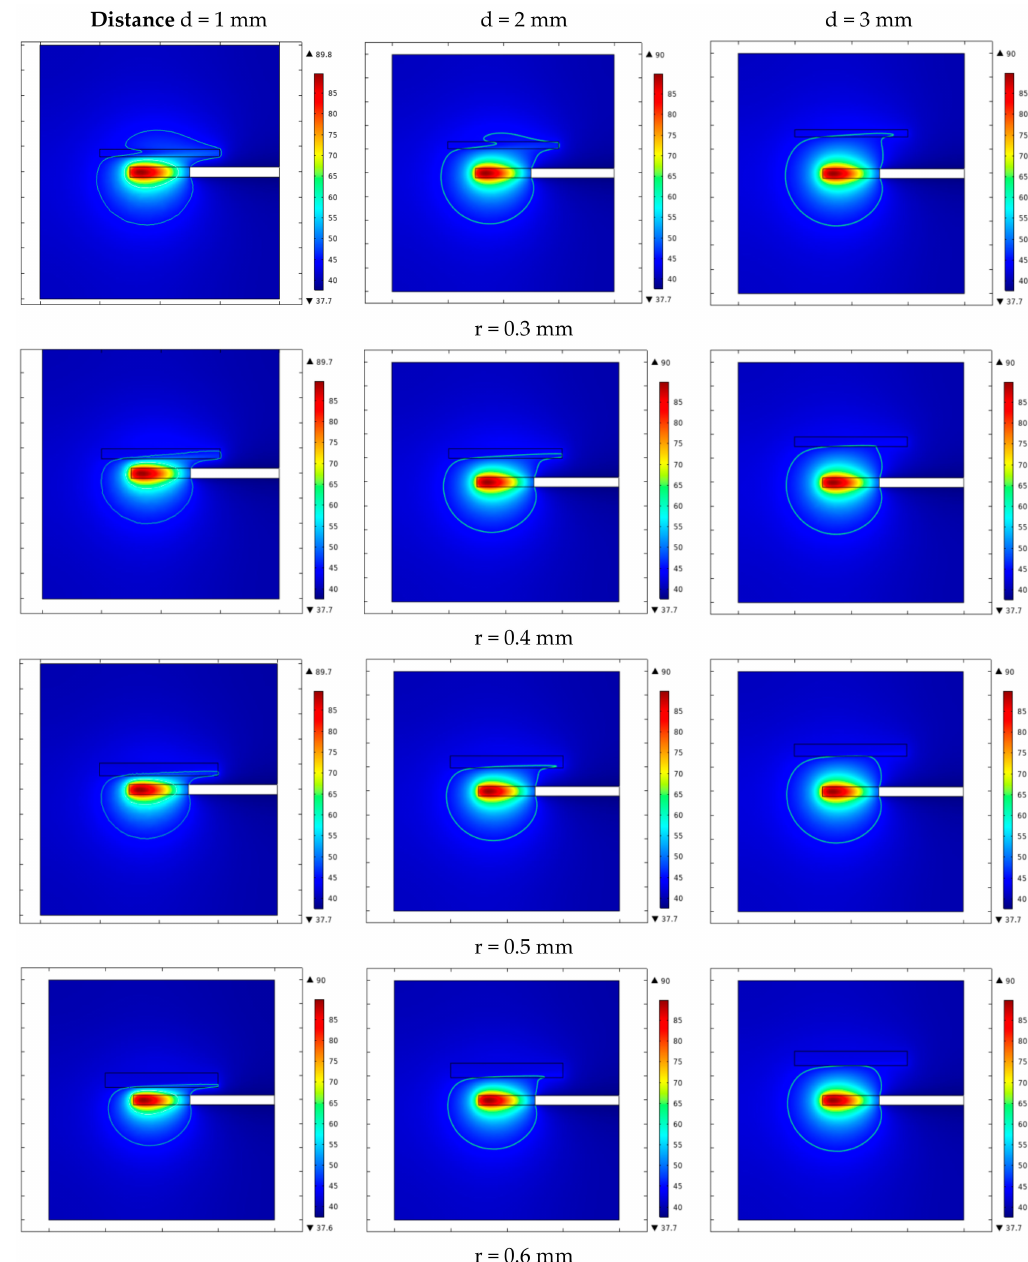
Figure 10. Temperature field distribution at different distances, each row indicates the same vessel radius of 0.3–0.6 mm, each column indicates the same distance between the fiber and the vessel of 1–3 mm, and the green line indicates the loss